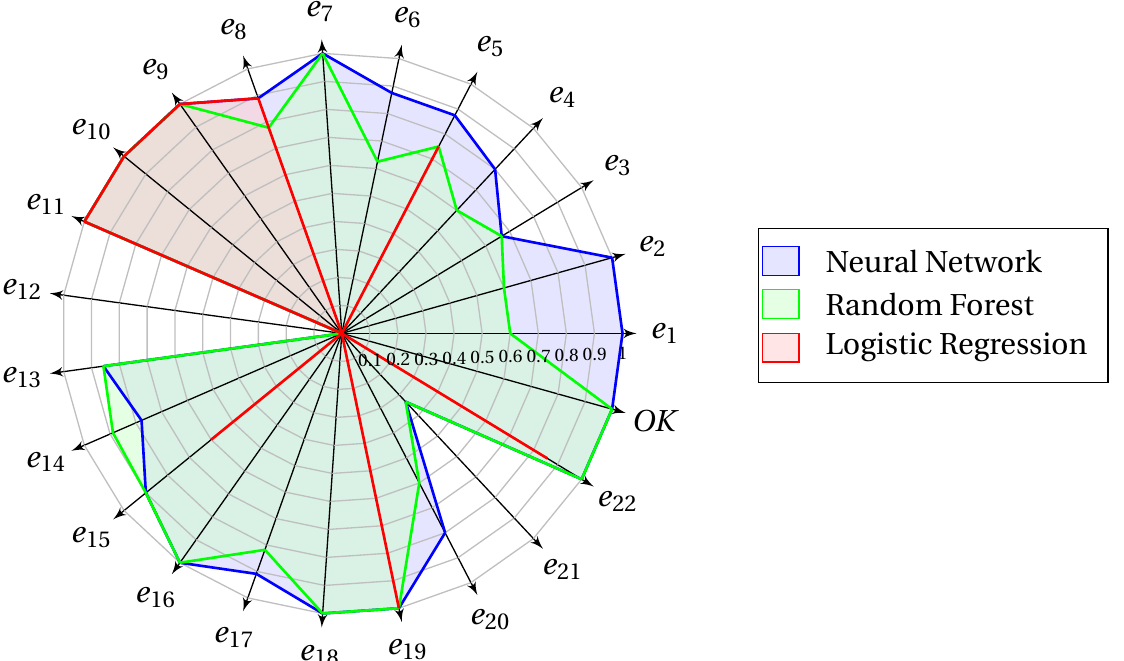
Figure 15. Comparison of the results of 3 applied methods machine learning in terms of f 1 .